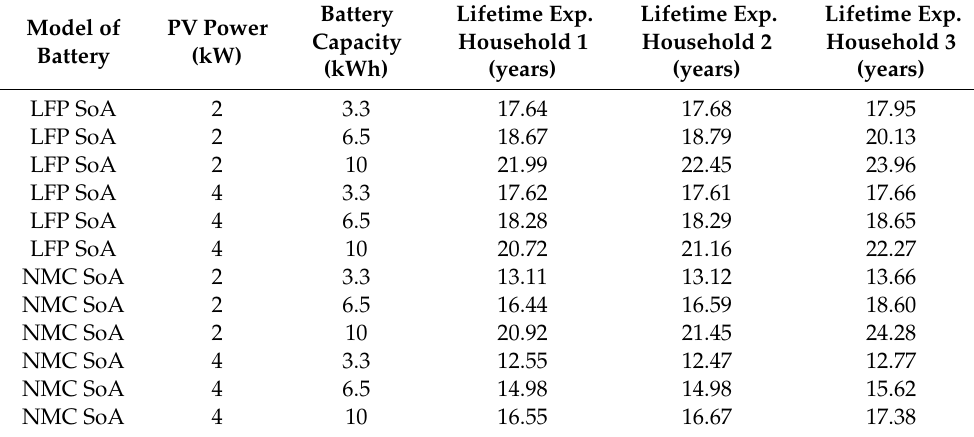
Table 6. Lifetime expectancy results for the LFP and NMC state-of-the-art battery packs installed at location B in any of the households